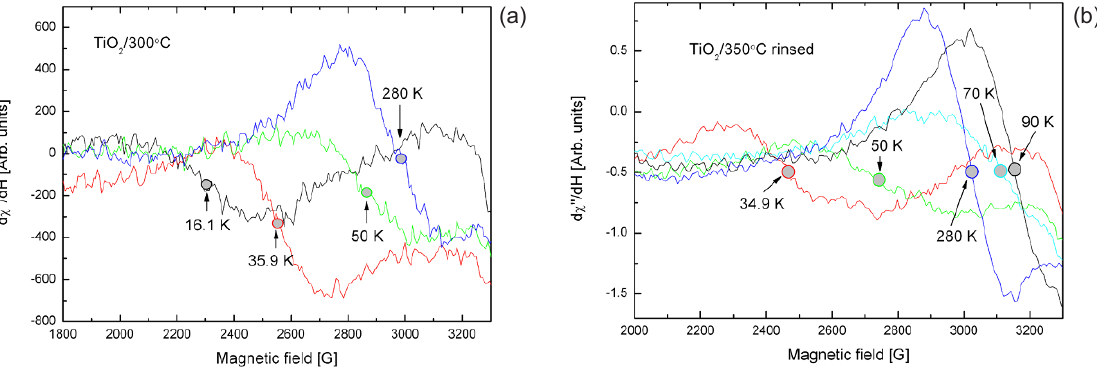
/300ºC] (a) and [TiO /350ºC rinsed] (b) at different temperatures demonstrating the 2 2